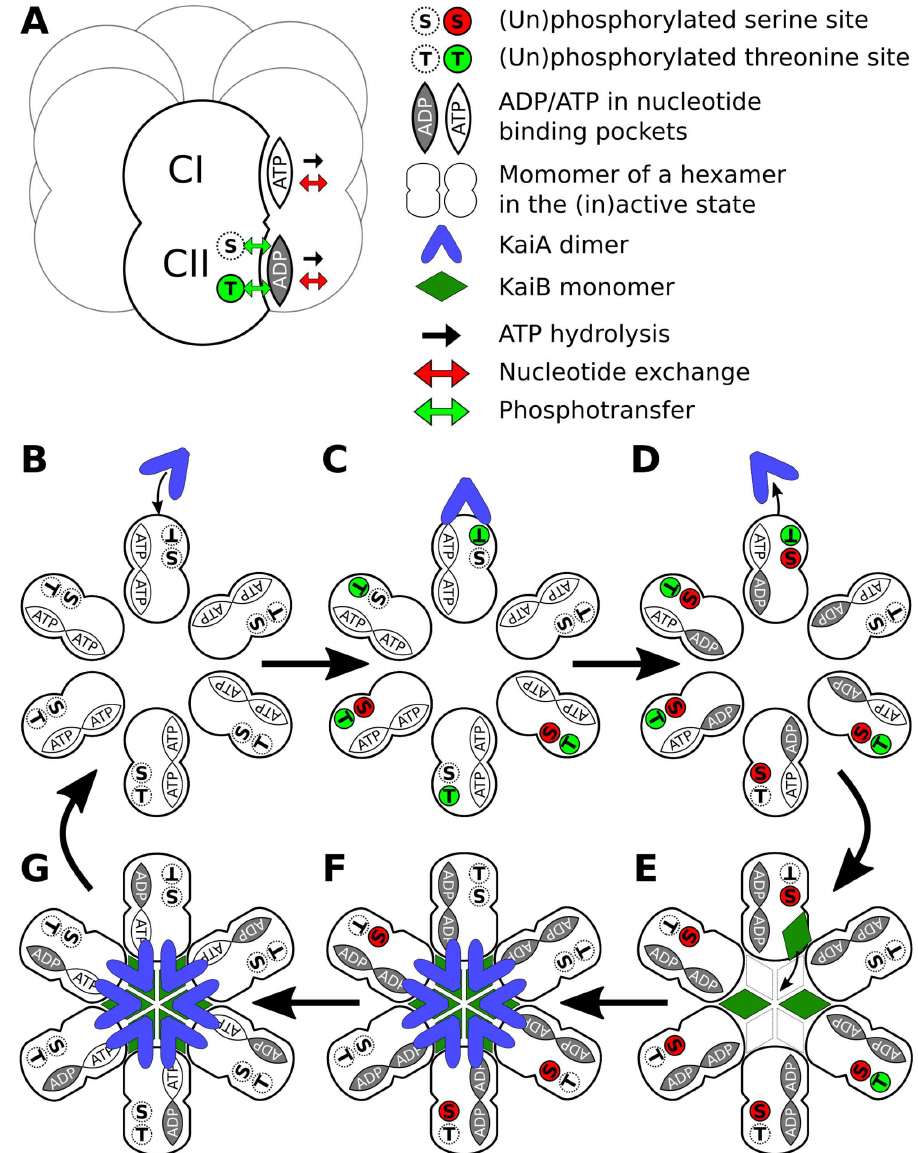
Fig 1. Overviewof the model and of how a hexamer progresses through its cycle. (A) KaiC hexamer with one monomerhighlighted.Each monomerconsists of a CI and a CII domain.Both domainscan bind nucleotides, but only the CII domaincan be phosphorylated, at a serine and a threonineresidue. In the cartoon shown, CI has ATP bound whileCII has ADP bound;in CII, the threonineresidue is phosphorylated whereasthe serineresidue is not. Arrows indicate allowedreactions: ATP bound to either domaincan be hydrolyzedto ADP, and bound ADP and ATP can be exchanged. The serine and threonineresidues in the CII domaincan be phosphorylated through phospho-transfer from a bound ATP and de-phosphorylated through phospho-transfer from the residue to a bound ADP. Panels B-G show a top view of the hexamerof panel A folded openfor reasons of clarity; in each monomer, the CI domainis towards the center and the CII domain towards the outside. They illustrate how the hexamertraverses a typical phosphorylation cycle in a buffer with ATP. Starting with an unphosphorylatedhexamerin the active state, the nucleotide exchangerate of the bindingpockets of the CI domain with the bulk will be high such that they have predominantly ATP bound. A singleKaiA dimer can bind to the CII domain,which enhances the nucleotide exchangerate in all the CII bindingpockets such that the probabilitythat ATP is bound increases.ATP in CII drives phosphorylation, where first the T sites and later the S sites are phosphorylated (C). When more serinesites than threonine sites are phosphorylated (D), the nucleotide exchangerate in the CI domain will drop and any remaining ATP in the bindingpockets of CI will be hydrolyzedso that most CI domainshave ADP bound.ADP in the